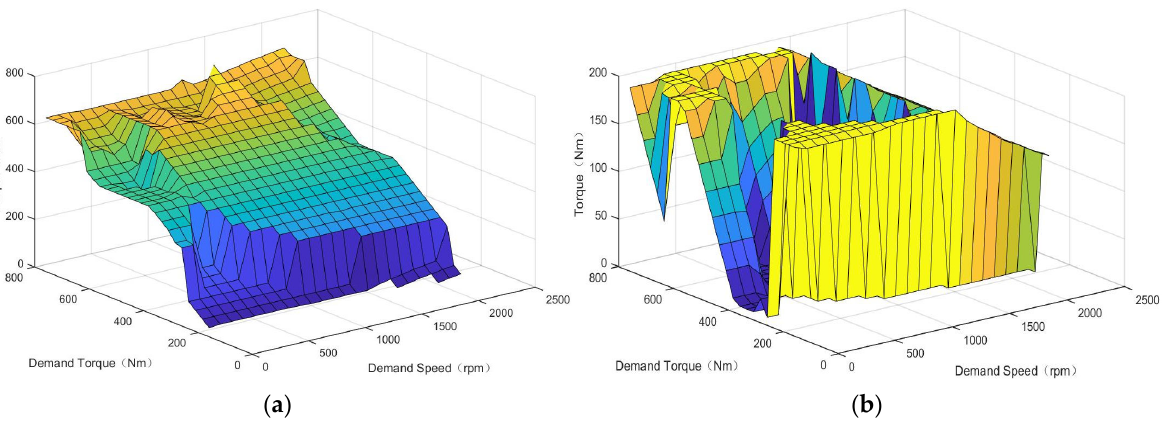
Figure 7. Torque distribution under hybrid drive. ( a ) Torque of the diesel engines. ( b ) Torque of the motor.